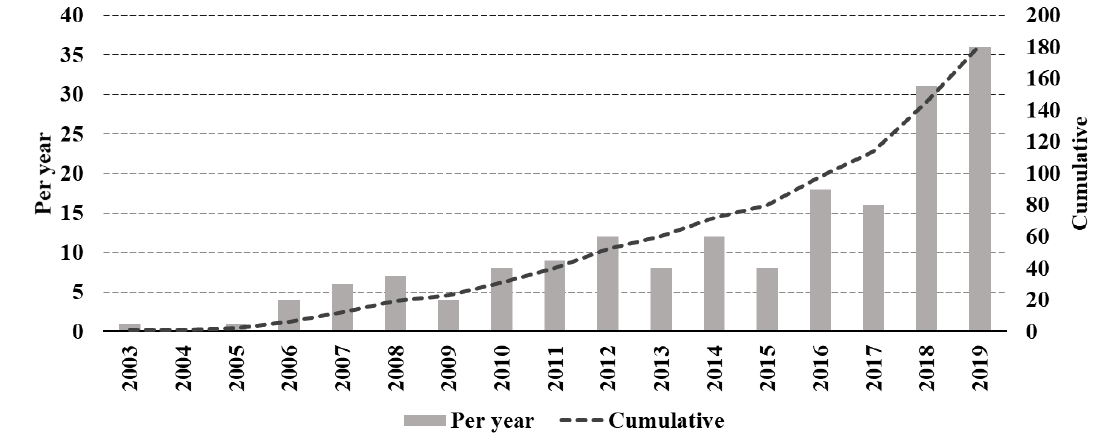
Figure 4. Number of papers published per year and total accumulated publications over